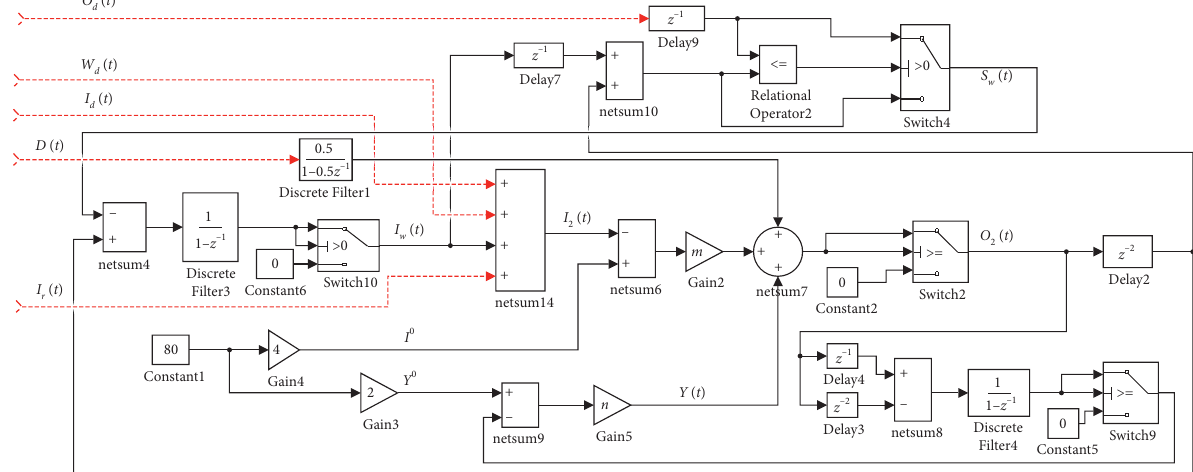
Figure 5: The block diagram of production and warehouse systems from the global decision perspective.